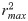
Population analysis.(a) Histogram of the best goodness-of-fit scores rmax2 over the entire population (n = 117 combinations of 68 neurons × 2 test frequencies that evoked significant responses). Significant scores (permutation test, p<0.05; see Methods) are indicated in red (n = 78/117, 67%). (b) Scatter plot of the largest fractions of explained variance achieved for the two frequencies tested with each neuron in the main analysis (n = 68). Neurons with significant rmax2 in both tested frequencies are indicated in red while neurons with significant rmax2 in only one frequency are indicated in gray. (c) Two-dimensional, color-coded population analysis histograms of the complexity and predictive power underlying the ‘good representations’ (i.e., reduced representations that achieved at least 90% of rmax2). Analysis was performed over combinations of neuron and frequency with rmax2≥0.1 (n = 34/117). Color scale (from blue to red) represents the fraction of neurons for which that combination was ‘good’. An abundance of 100% (red color) means that this combination of parameters was in the ‘good’ set of parameters for each and every neuron in the analyzed population. (d) Same analysis as in panel c, results are shown as a function of past duration and complexity. The 50% contour in the plot is marked by the white line. (e) Same analysis as in panel c, results are shown as a function of past duration and predictive power. Panels d and e use the same color-code as panel c.